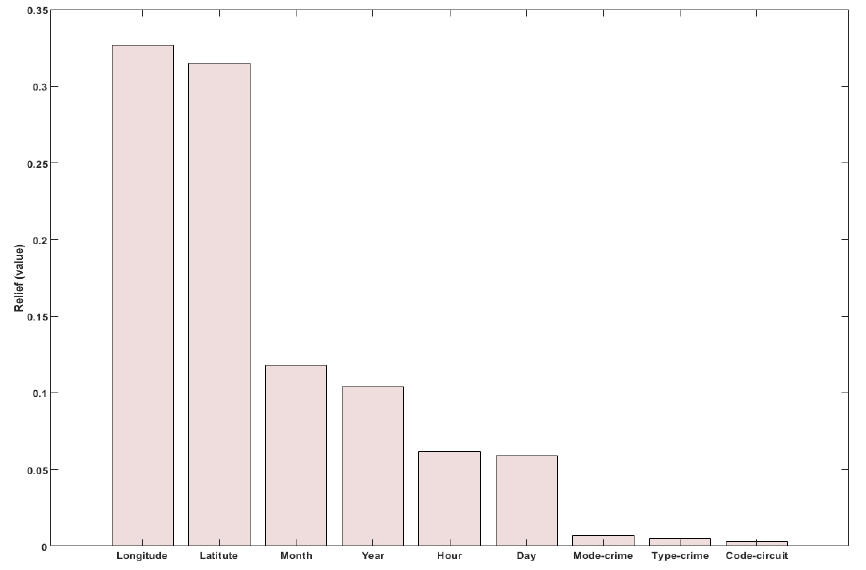
Figure 4. Feature selection using the Relief